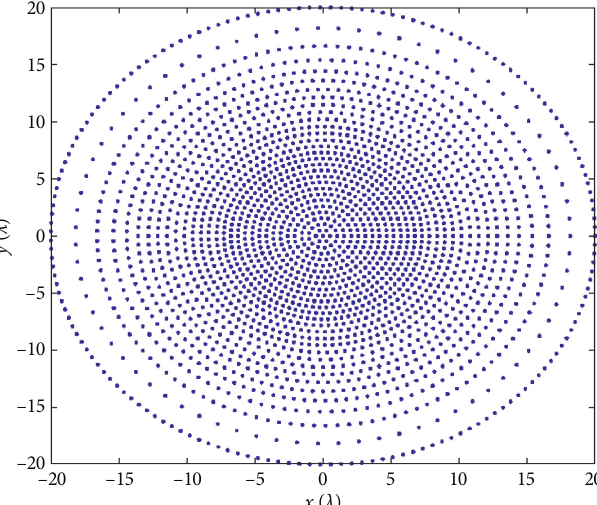
Figure 5: Element distribution of the UECRA when N � 2256.